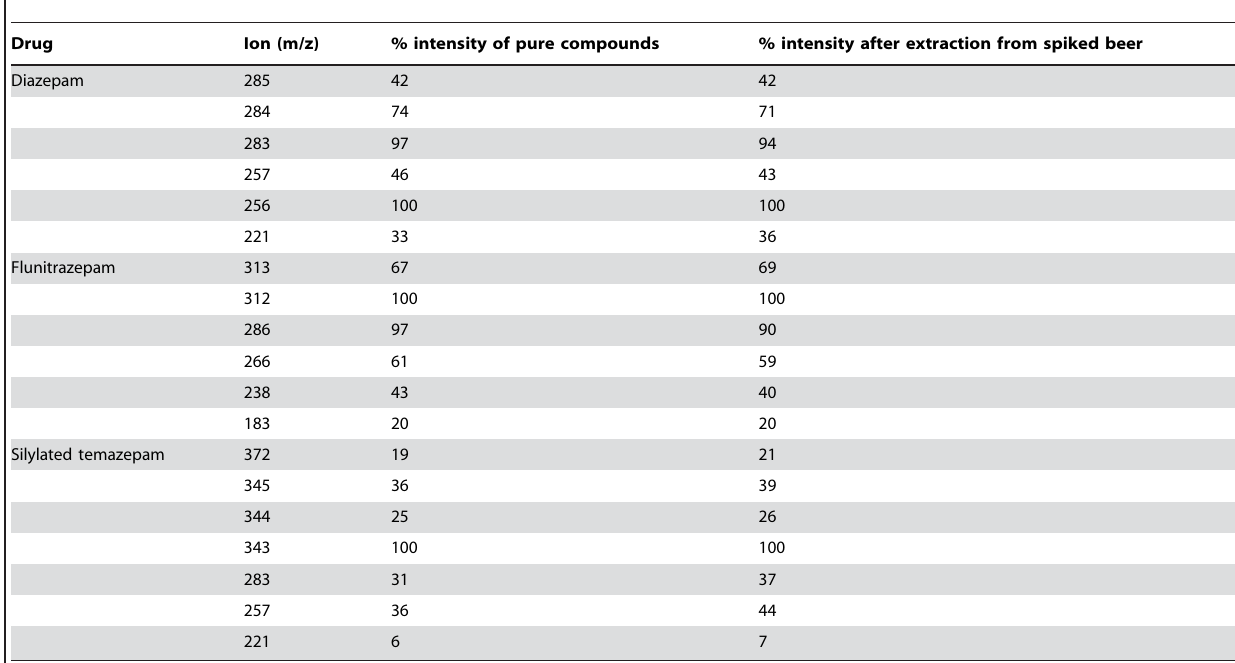
Table 2. Mass spectrometry data for diazepam, flunitrazepam and silylated temazepam as pure compounds and after extraction from beer as exemplar data.